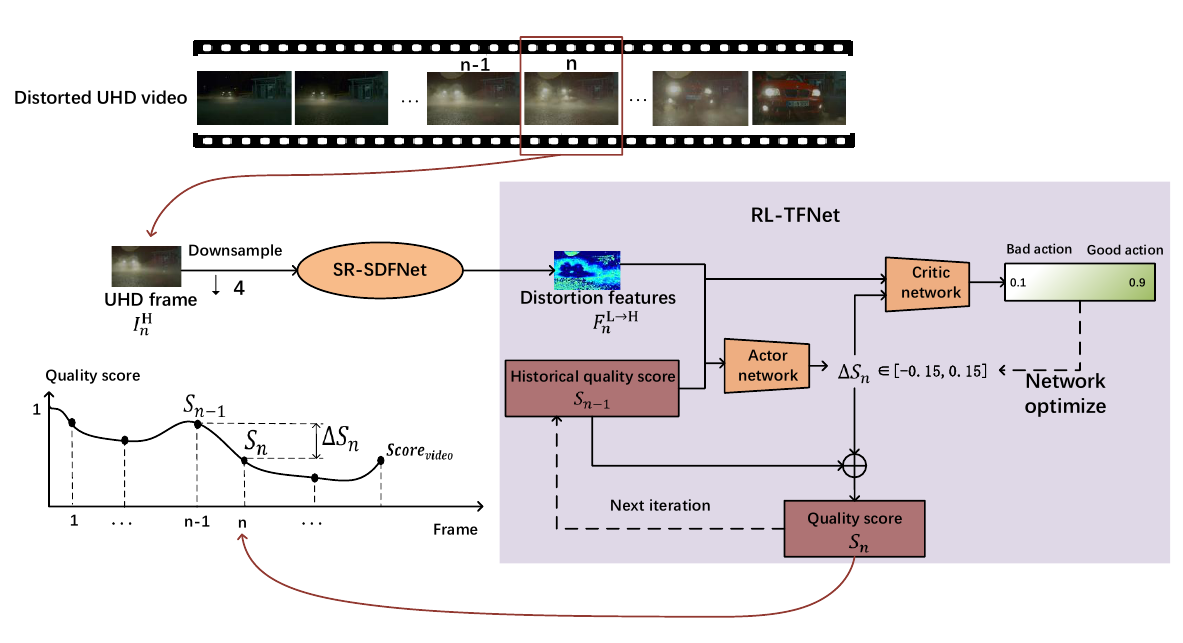
Figure 6. The processing pipeline of the time fusion network based on reinforcement learning